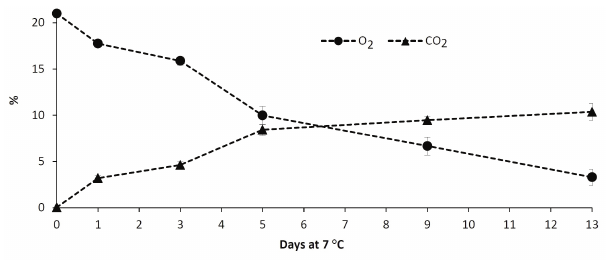
Fig. 1 ­ Changes in gas composition of goji berries stored in pMAP for 13 days at 7°C (±1). Values are means of three replicates for each storage time ± standard